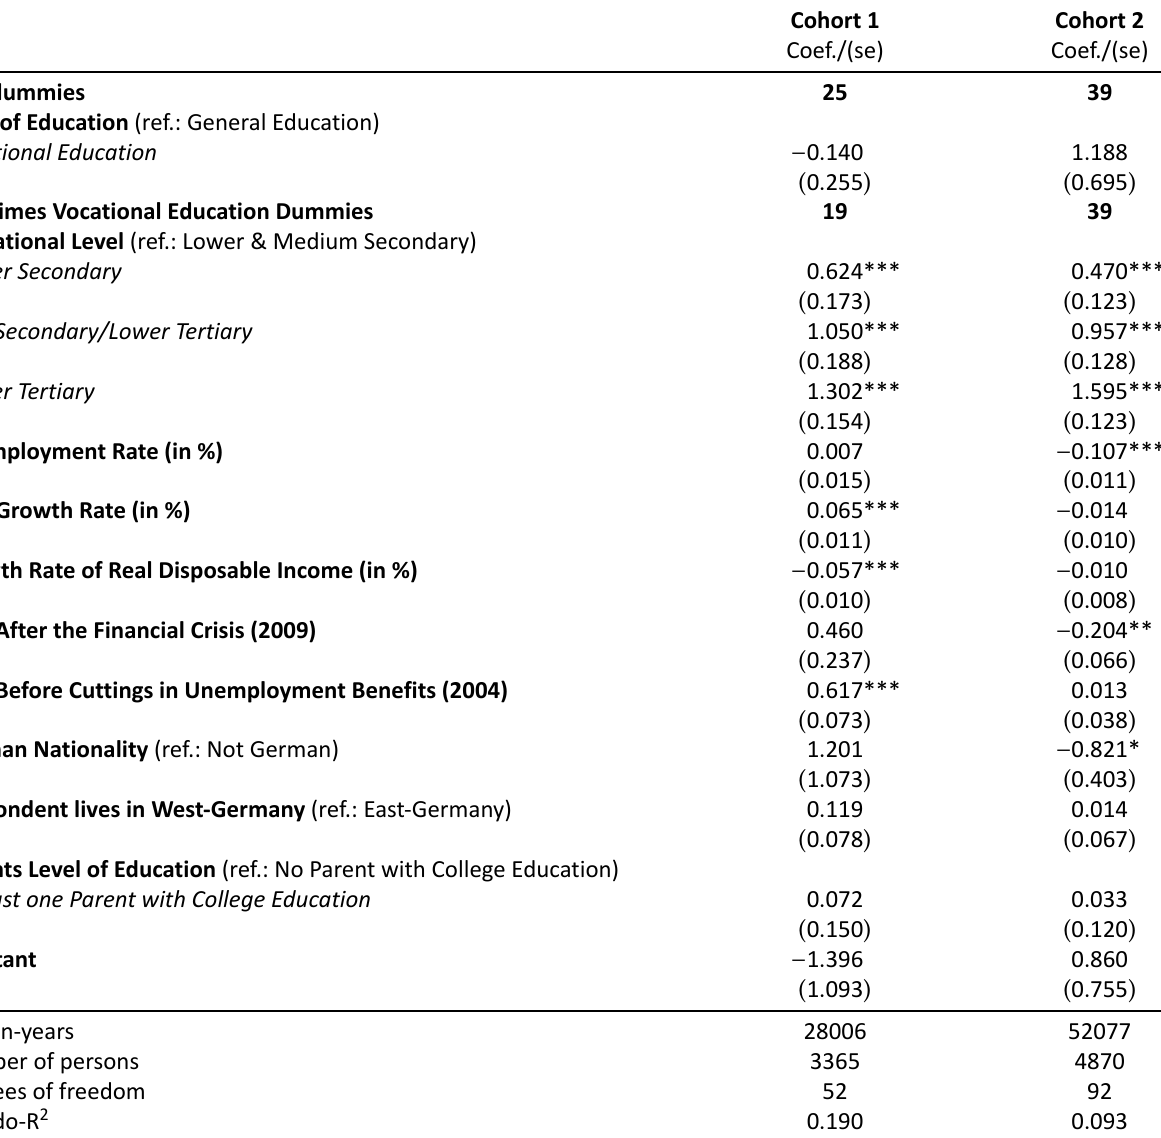
Table A5. Employment opportunity over the life course: General versus vocational education by cohort (women). Data source: GSOEP